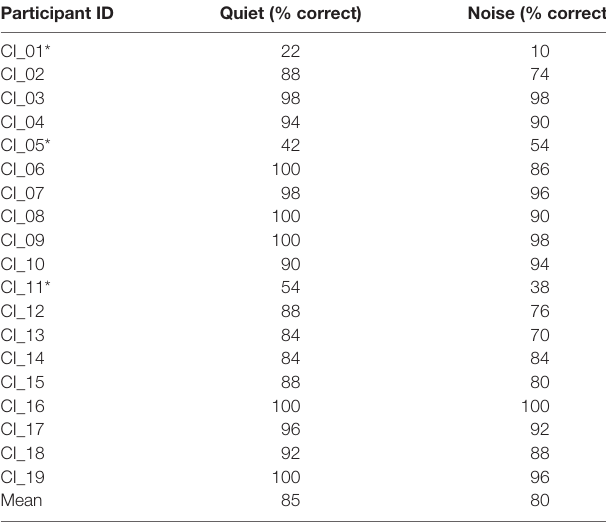
TABLE 3 | Summary of each CI user’s speech perception test scores in quiet and in noise ( N = 19).